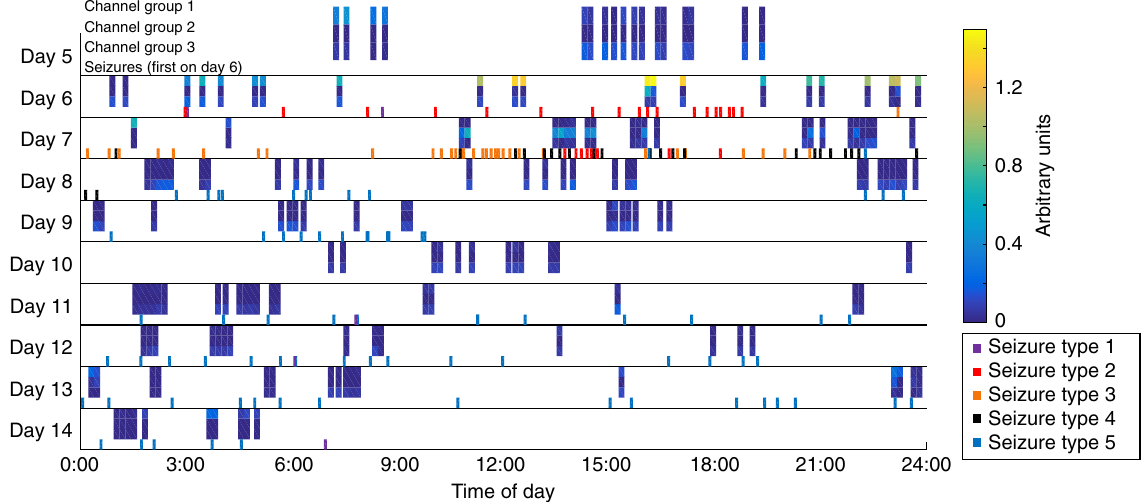
Fig. 5 Time of seizures versus HFO rates. The effective HFO rates per channel group for patient UM-07 during interictal NREM periods (using the same scheme shown in Fig. 3d) are plotted at the time of day of each epoch to indicate relative activity of each group for a given time. Tricolor vertical bars indicate the three channel groups. The starting time of each seizure (including subclinical seizures) is also denoted as short vertical lines at the bottom of each row, color coded for seizure type. Colorbar: relative strength of each HFO channel group. Note that different HFO groups become active prior